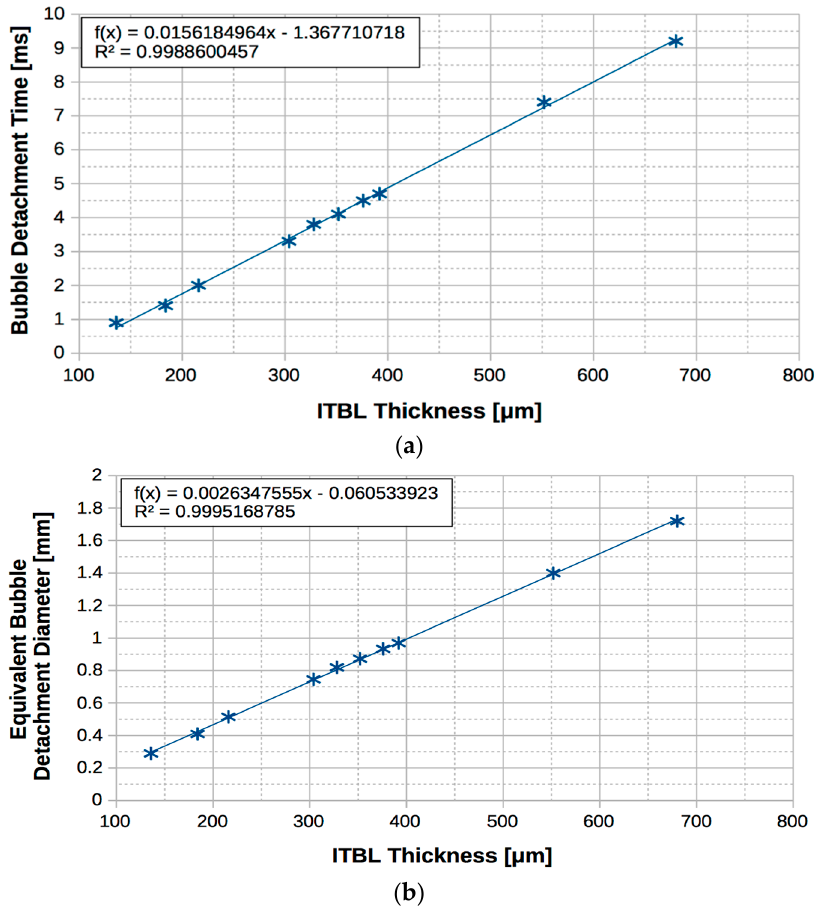
Figure 13. Effect of ITBL thickness on: ( a ) the bubble detachment time; ( b ) the equivalent bubble detachment diameter.